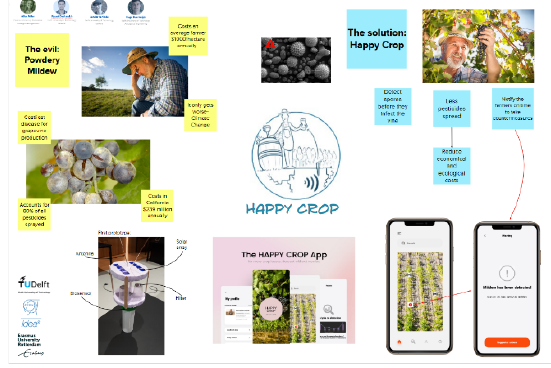
Fig. 3. A poster to present our idea to the